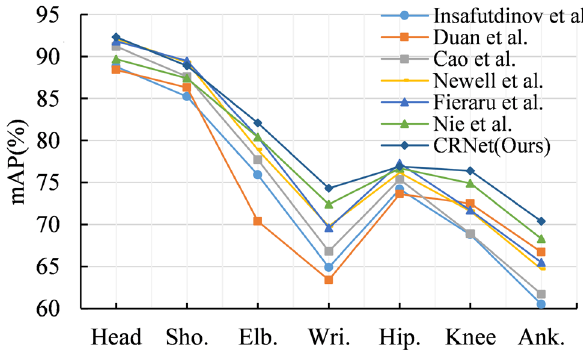
Figure 6: Comparison of prediction accuracy of all keypoints.